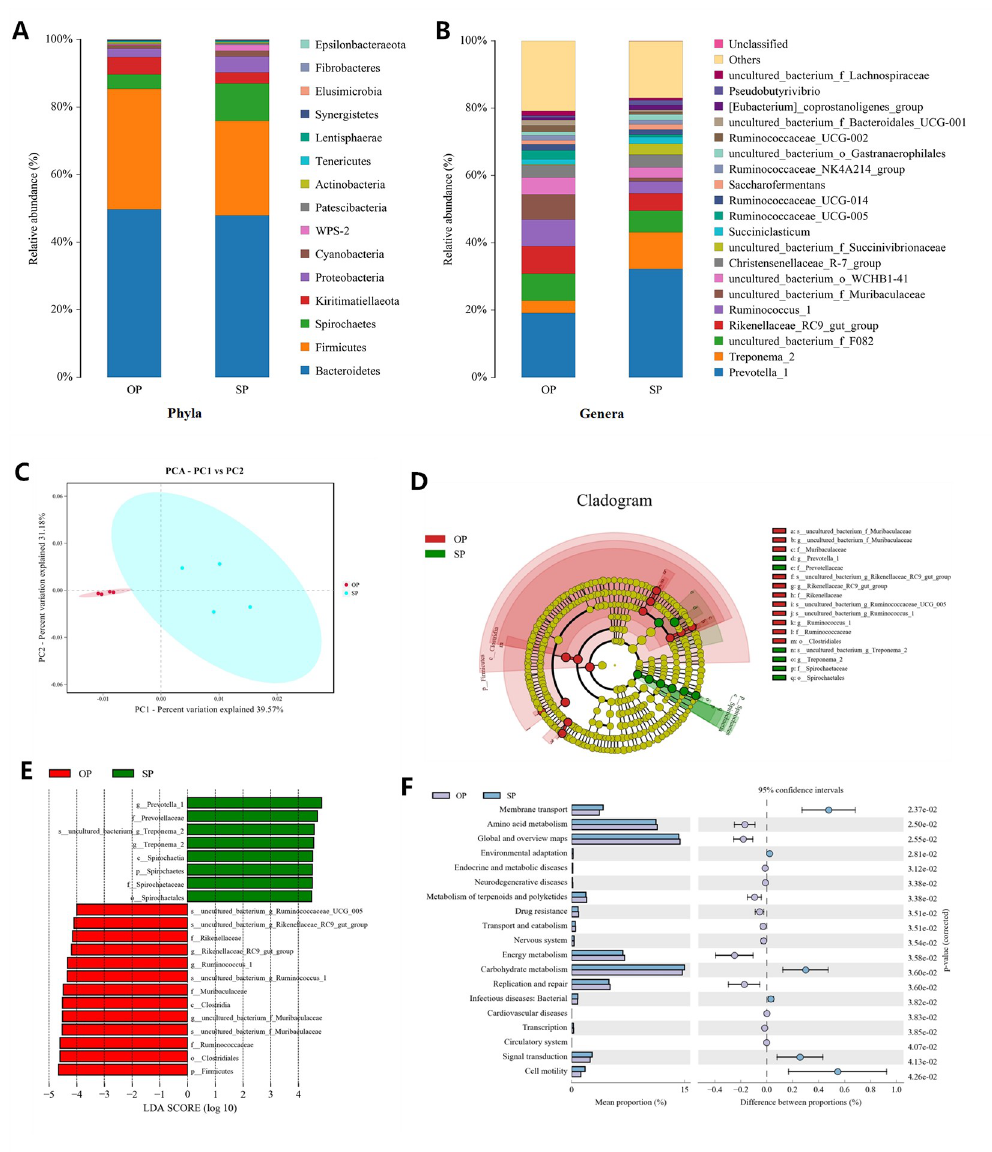
Fig 3. 16S rRNA genes sequencing analysis of bacterial diversity in rumen fluid. (A) Phyla- and (B) genera-level composition of the rumen bacteria (top 20); (C) PCA analyses of beta diversity; (D) LEfSe analysis indicated the biomarker bacteria and (E) Histograms of linear discriminant analysis (LDA) for the differential biomarker; (F) KEGG annotates the differential functional genes of bacterial communities. OP, oscillating crude protein concentrations diet; SP, static protein